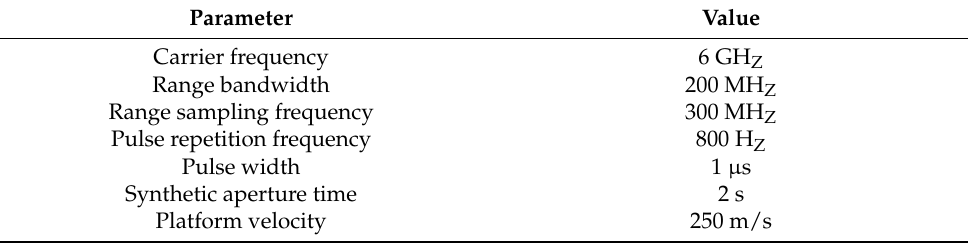
Table 1. System parameters of